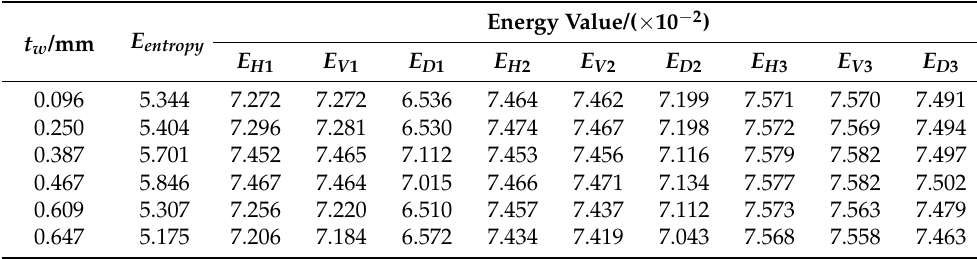
Table 3. Energy value and information entropy of sub-images corresponding to different corrosion depths.